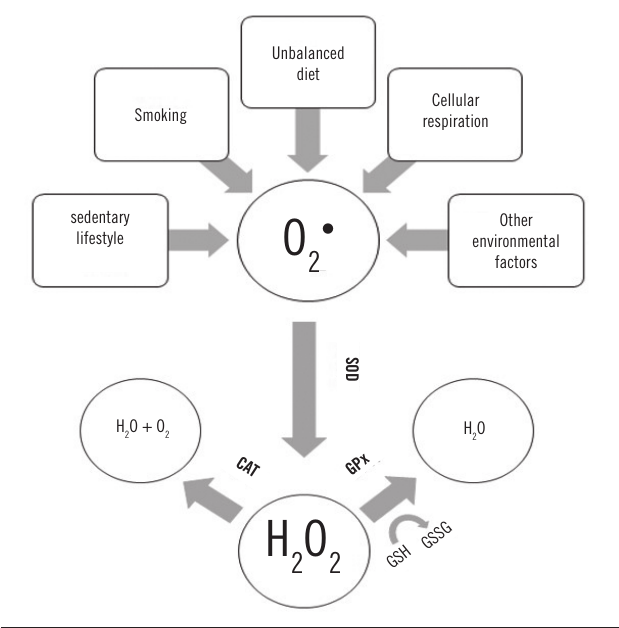
figuRE − Generation and neutralization of ROS by activity of antioxidant enzymes SOD, CAT and GPx leading to transformation of GSH into GSSG ROS formation is induced by cellular respiration and external factors, such as physical inactivity, smoking and unbalanced diet. In order to reduce oxidative stress, SOD catalyzes •- ) into hydrogen peroxide (H O ). CAT and GPx the dismutation of superoxide anion (O 2 2 2 play an important role converting this reactive species into water (H O) and molecular 2 oxygen (O ). Modified from Roberts, 2